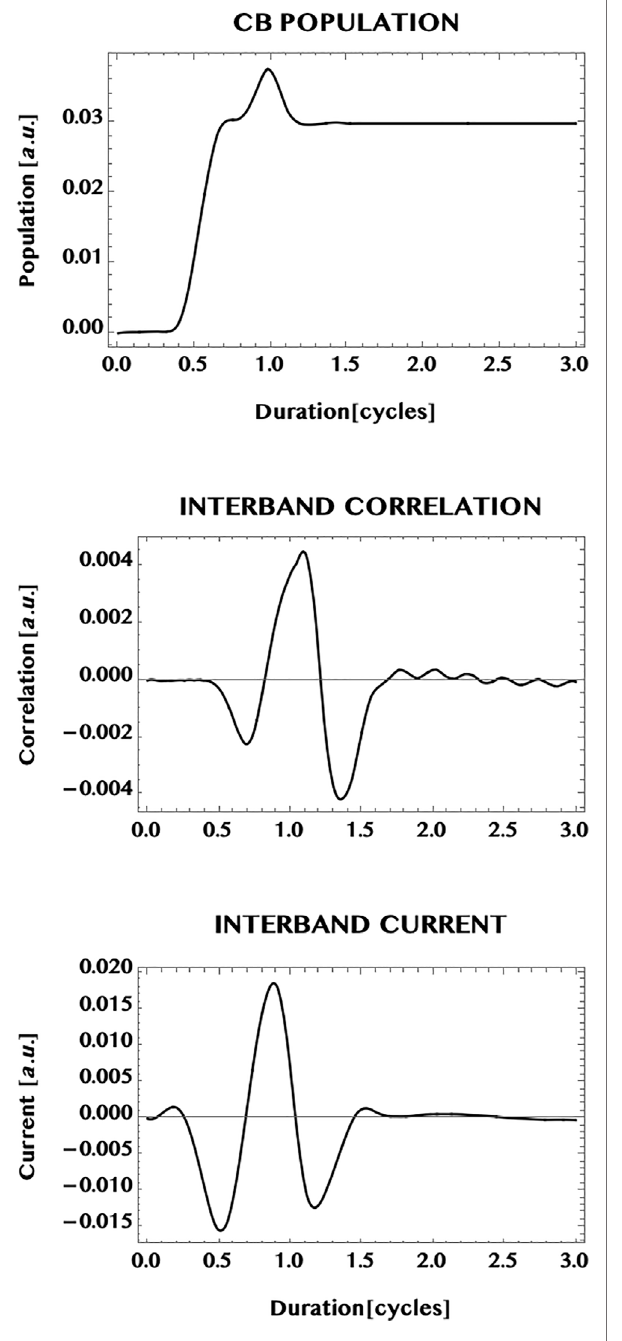
FIGURE 8 | Response of a graphene monolayer to an intense ultrashort laser pulse. Pulse parameters are: wavelength = 800 nm, peak intensity = 1 TW/cm 2 ,pulse duration =1.5cycles, CEP =0;simulationperiod =3cycles. Top panel: normalised population excited in the conduction band (CB); middlepanel:normalised inter band “ coherence ” (orcorrelation).Shownalsois the normalised inter band current (bottom panel). Note the near steady population in the CB and an oscillatory inter band coherence after the pulse is over. The inter band current (being a 2D integrated sum of the inter band coherence wighted by the k-dependent current operator) shows only a mild modulation for the 2D monolayer (in comparison with a 1D ribbon that is con fi ned along the width dimension (cf. also Figures 9 , 10 below).